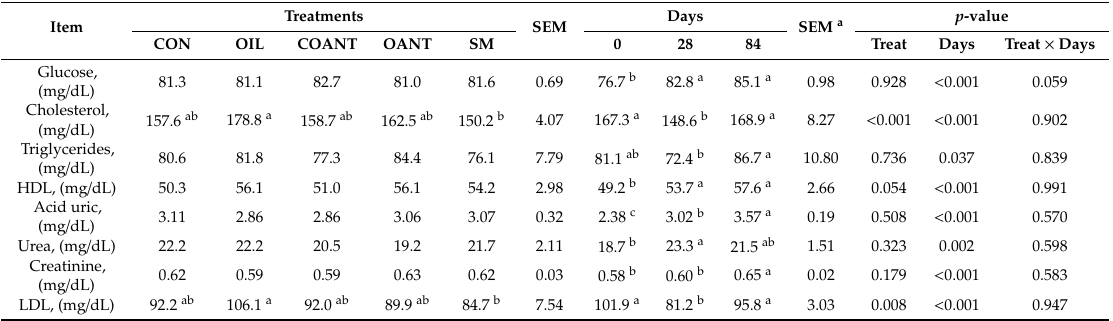
Table 5. Blood metabolites in children according to treatments and collection